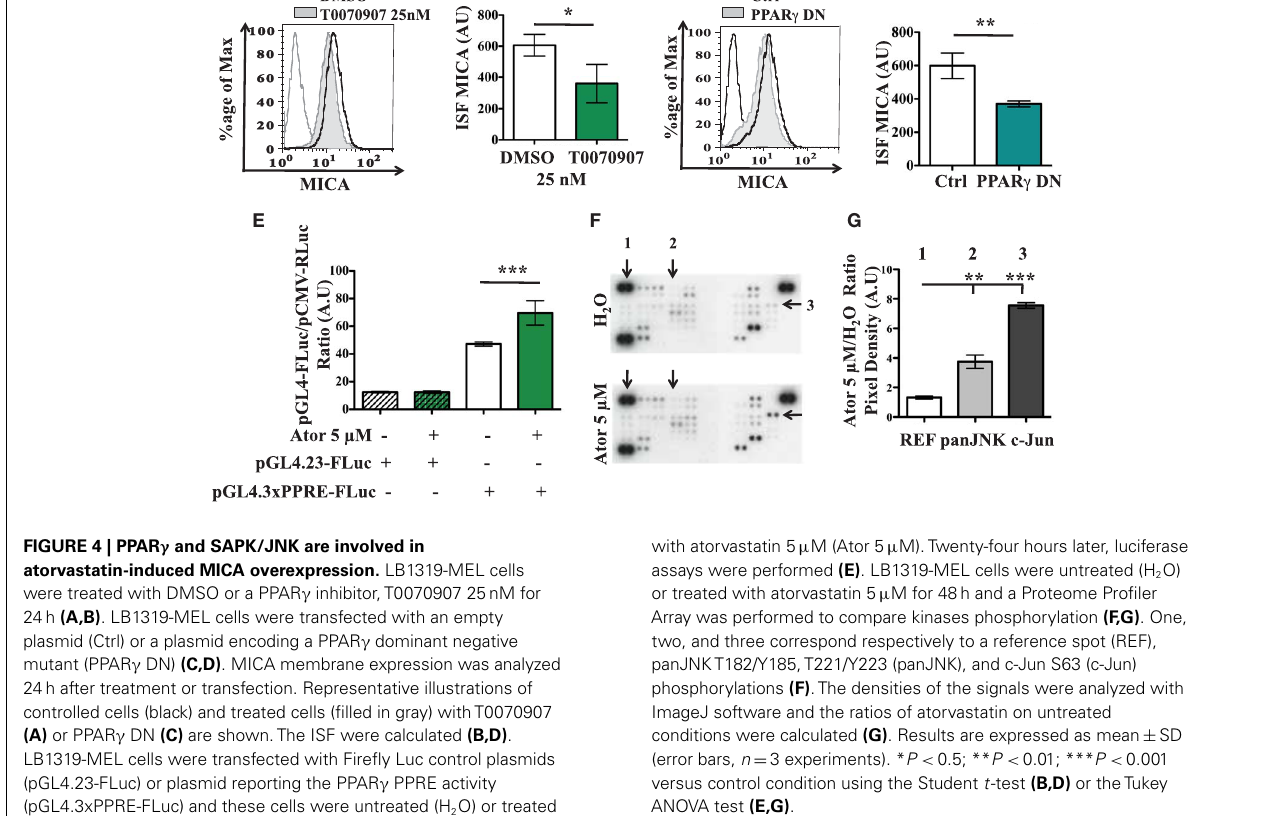
with atorvastatin 5 µ M (Ator 5 µ M).Twenty-four hours later, luciferase assays were performed (E) . LB1319-MEL cells were untreated (H 2 O) or treated with atorvastatin 5 µ M for 48h and a Proteome Profiler Array was performed to compare kinases phosphorylation (F,G) . One, two, and three correspond respectively to a reference spot (REF), panJNKT182/Y185,T221/Y223 (panJNK), and c-Jun S63 (c-Jun) phosphorylations (F) .The densities of the signals were analyzed with ImageJ software and the ratios of atorvastatin on